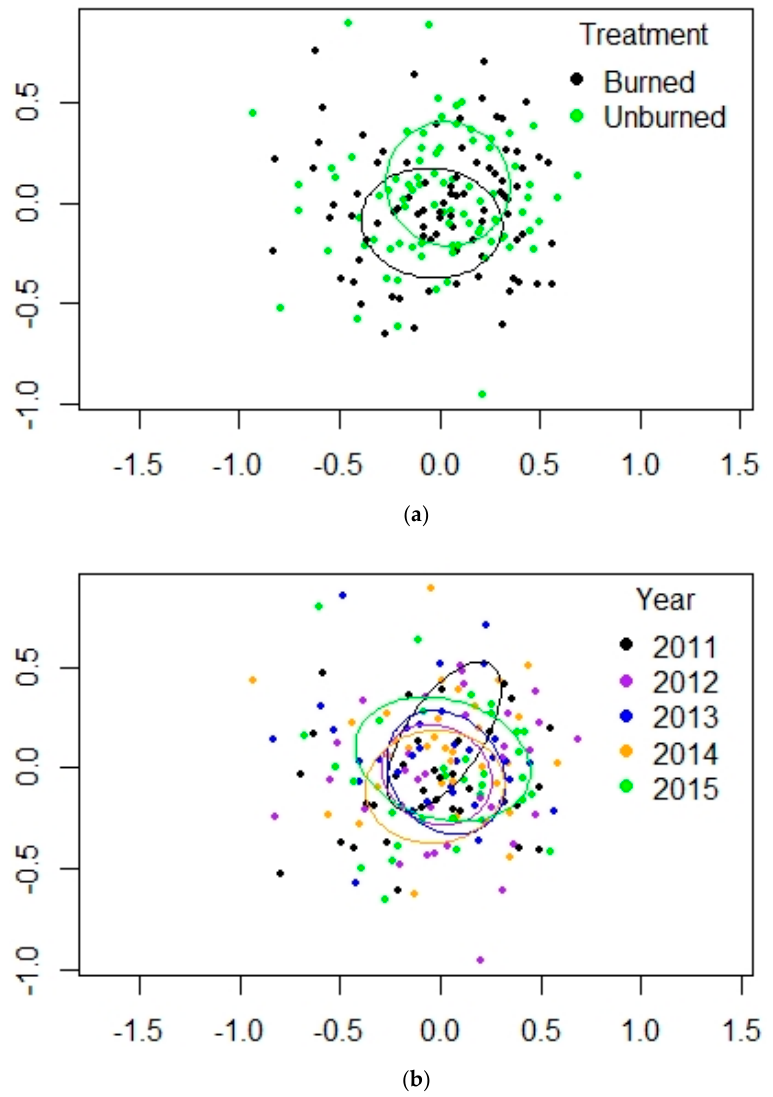
Figure 6. ( a , b ). NMDS plots for PERMANOVA results for mountain valley grassland at Valles Caldera. ( a ) treatment, ( b ) year. Ellipses are the 95% confidence intervals for the locations of the centroids. Table 3. Arachnid community SIMPER results by treatment and year for Ponderosa Pine Forest, Mixed-conifer Forest, and Mountain Valley Grassland at the Valles Caldera National Preserve. Ponderosa Pine Forest Mixed-conifer Forest Mountain Valley Grassland